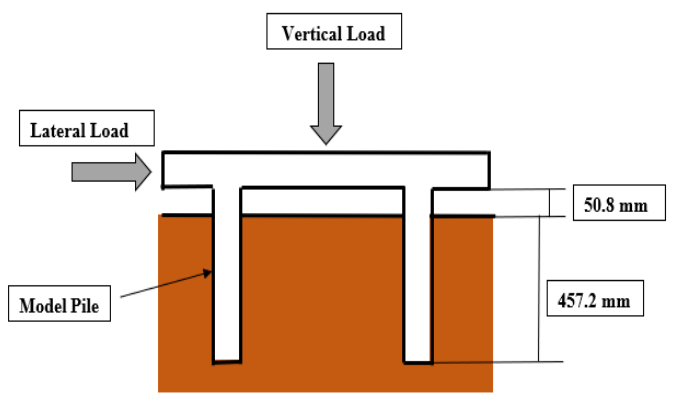
Figure 13. Pile group arrangement.